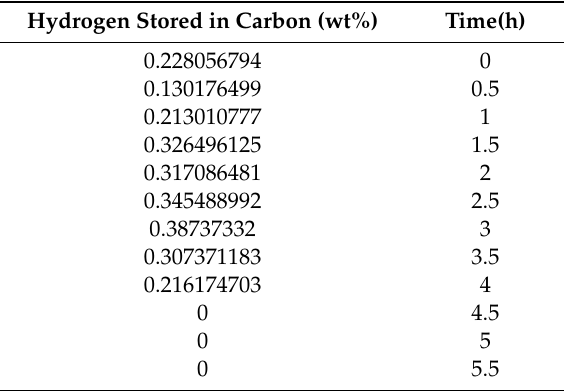
Figure 17. Graph showing the relation between wt% of hydrogen stored in carbon and time during charging of modified unitized regenerative fuel cell (URFC) or proton battery. Table 12. X and Y axis variable values of the active points shown in Figure 17.